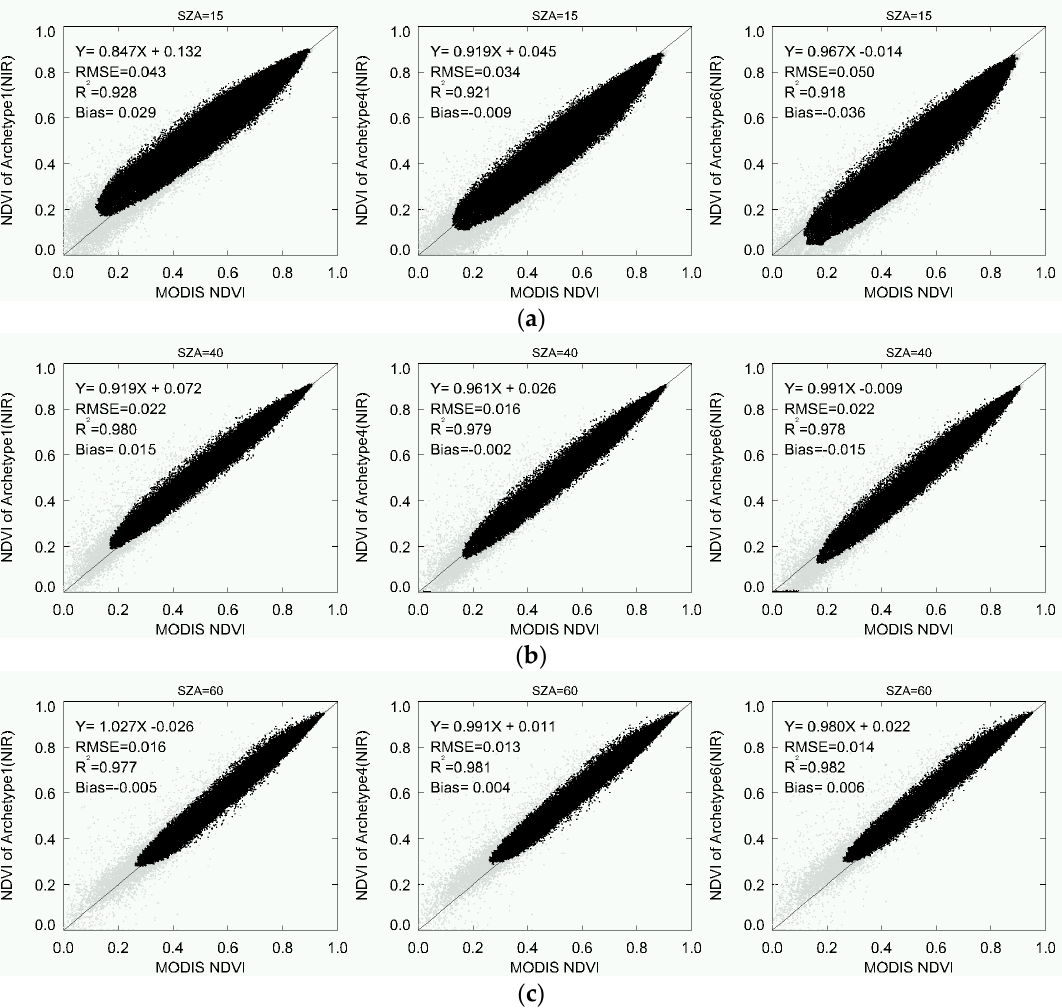
Figure 10. Comparison of the MODIS NDVI and NDVIs retrieved from different archetypal BRDFs. ( a – c ) refer to the result at solar zenith angle of 15°, 40°, and 60°. Three columns represent the result of archetypal BRDF Nos. 1, 4, and 6.